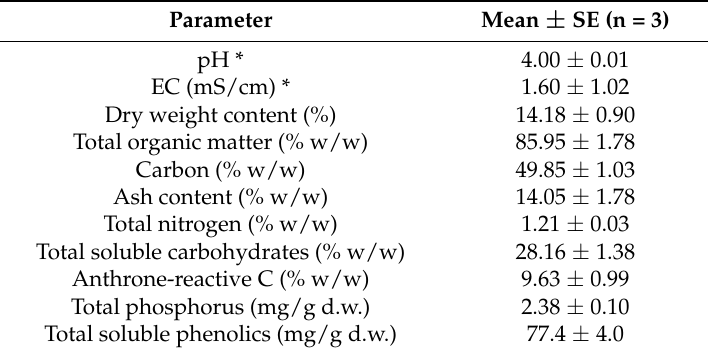
Table 1. Physicochemical traits of orange juice processing waste.